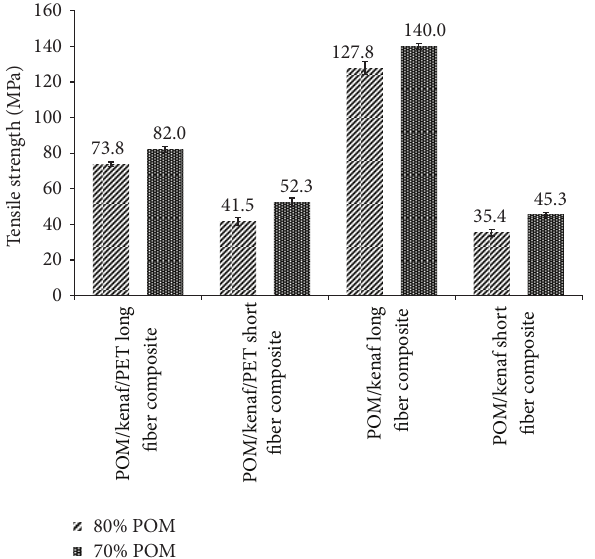
Figure 1: Tensile strength of the controlled samples.